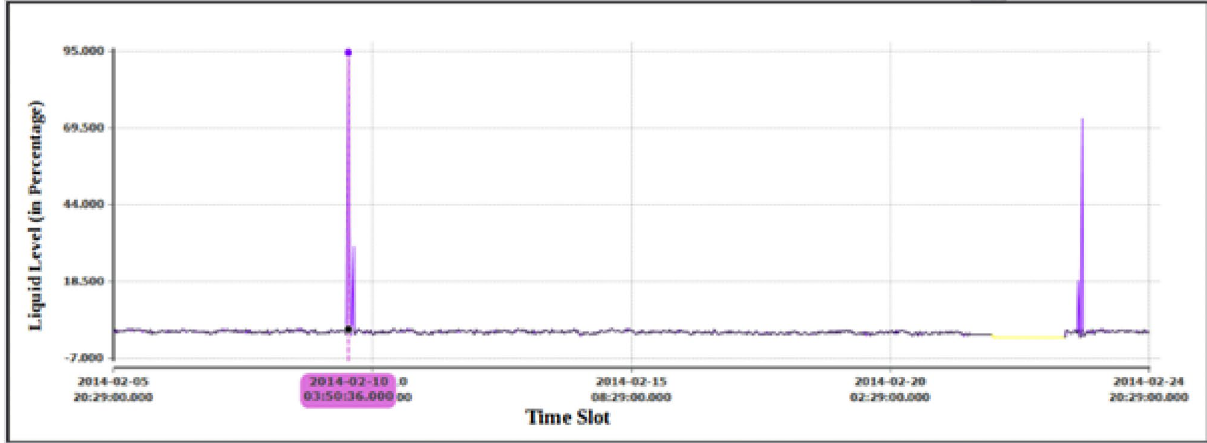
Figure 17. Case 2. sudden increase in liquid level of the bottom of the